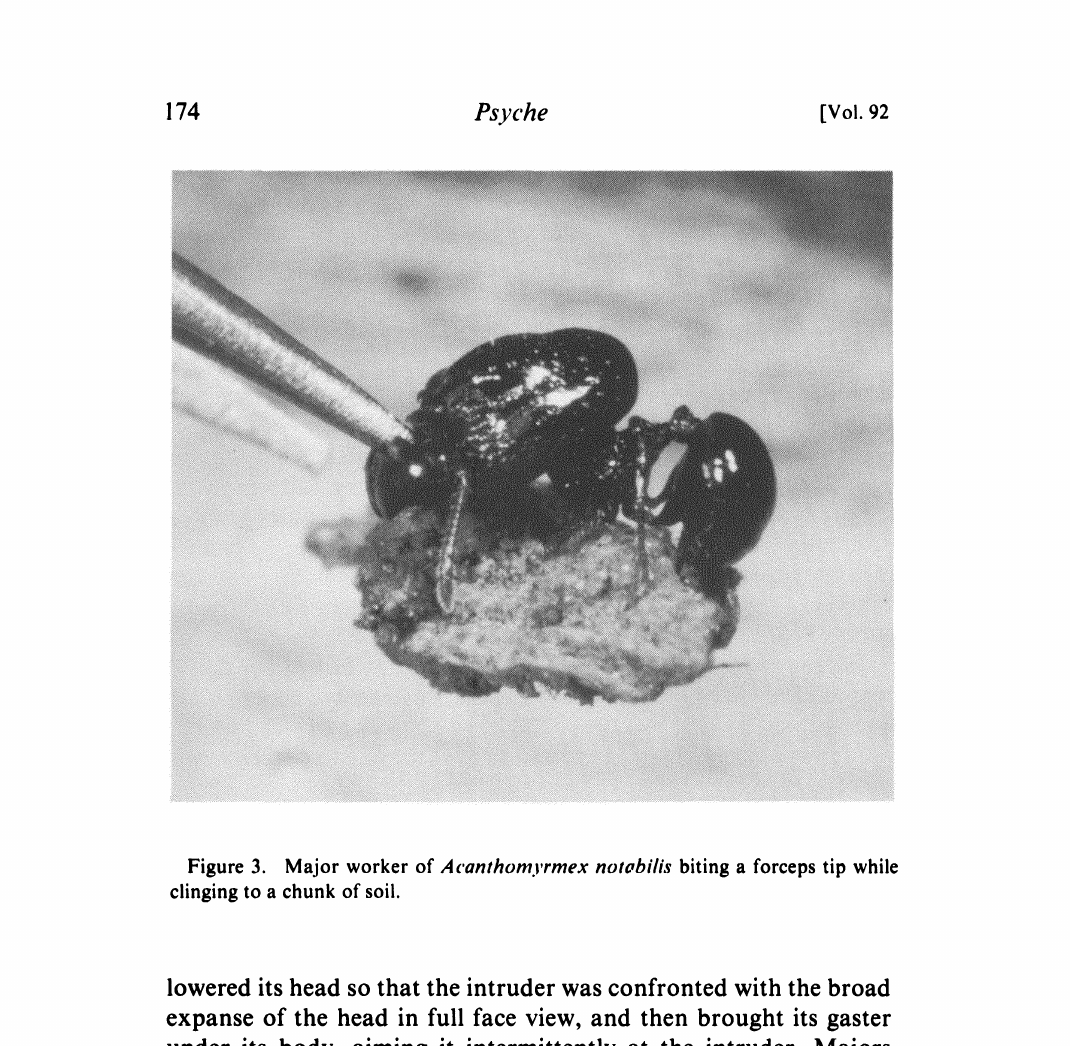
Figure 3. Major worker of Acanthomyrmex notabilis biting a forceps tip while clinging to a chunk of